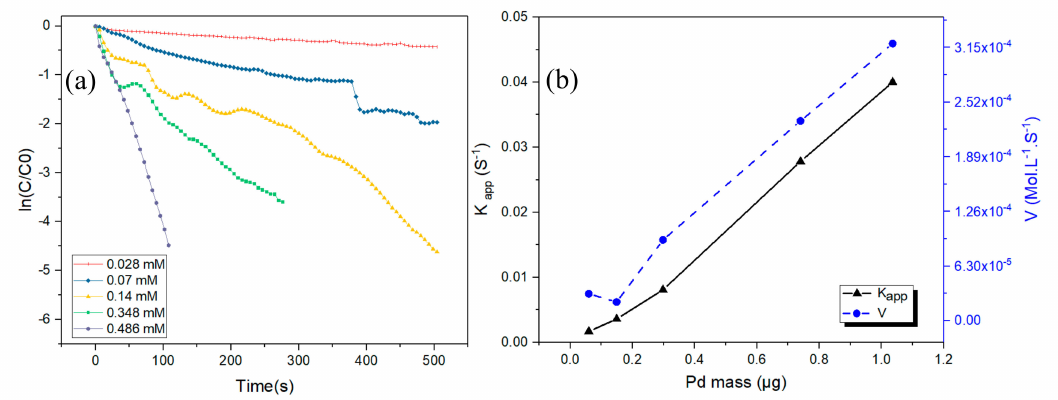
Figure 5. ( a ) ln ( C / C 0 ) versus time at di ff erent concentrations of Pd nanoparticles. ( b ) Plots of k app and initial velocity (rate) versus the amount of Pd nanocatalyst; conditions of the reaction at 150 eq NaBH 4 ; [4-NIP] = 7.38 × 10 − 5 M; temperature 25.5 ◦